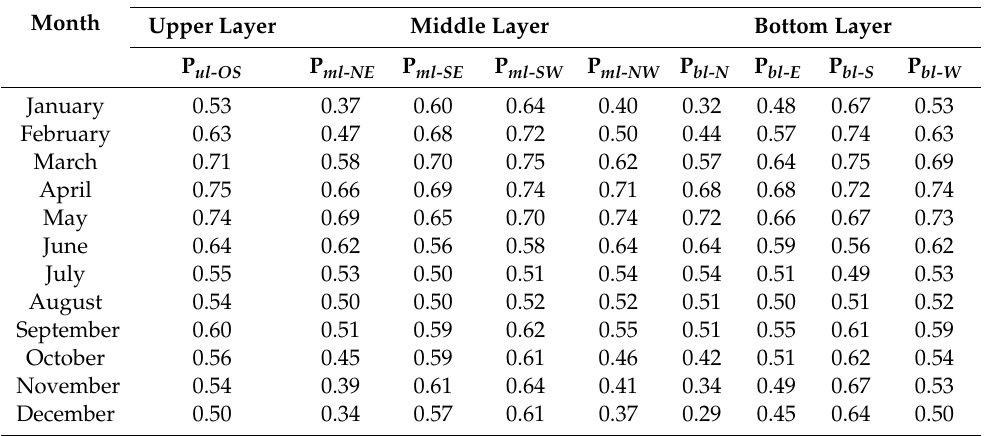
Table 5. Monthly average of daily energy outputs of c-Si photovoltaic leaves in the three di ff erent layers of the solar photovoltaic tree.